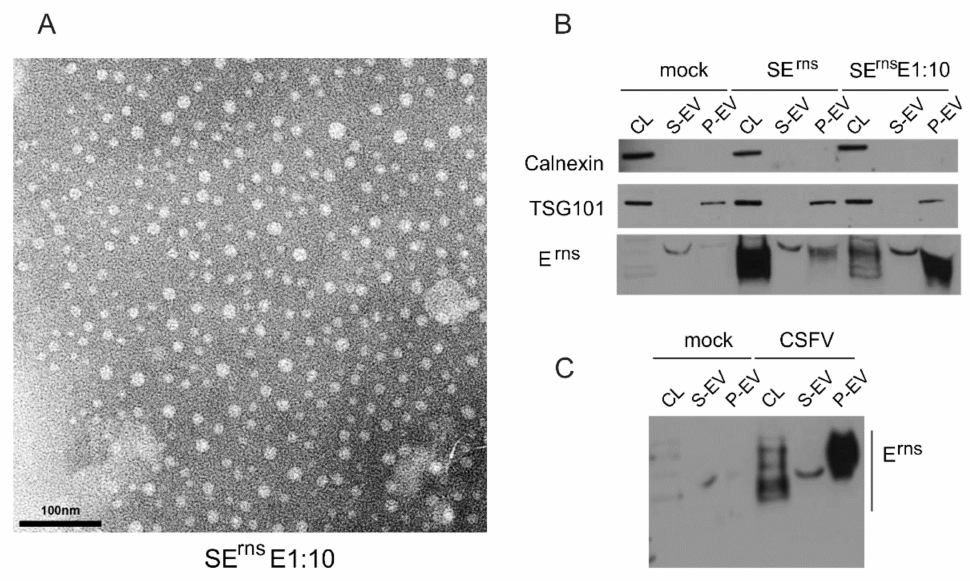
Figure 10. E rns copurifies with extracellular vesicles. ( A ) Electron microscopic picture of a typical preparation of extracellular vesicles from the supernatant of cells expressing SE rns E1:10. Differences from this picture with regard to number or morphology were not observed when preparations from cells expressing wt E rns or naive cells or pestivirus infected cells were analyzed. ( B ) Western Blot with samples produced during EV enrichment. Cultures of non-transfected BHK-21 cells infected with Vaccina virus MVA-T7 (mock), and cells expressing E rns wt (SE rns ) or the super-secretion variant mutant SE rns E1:10 served as starting material. Supernatant of the cultures was subjected to vesicle enrichment via the ExoQuick-TC kit resulting in a vesicle containing pellet fraction (P-EV) and a vesicle-free supernatant (S-EV). For control purposes, lysates of the corresponding cells were analyzed (CL). Antibodies against calnexin (upper panel, marker for cell resident proteins), TSG101 (marker for EVs/exosomes, middle panel) and E rns (lower panel) were used for Western blot. ( C ) same as in B but with SK6 cells infected with CSFV Alfort/Tübingen or SK6 mock